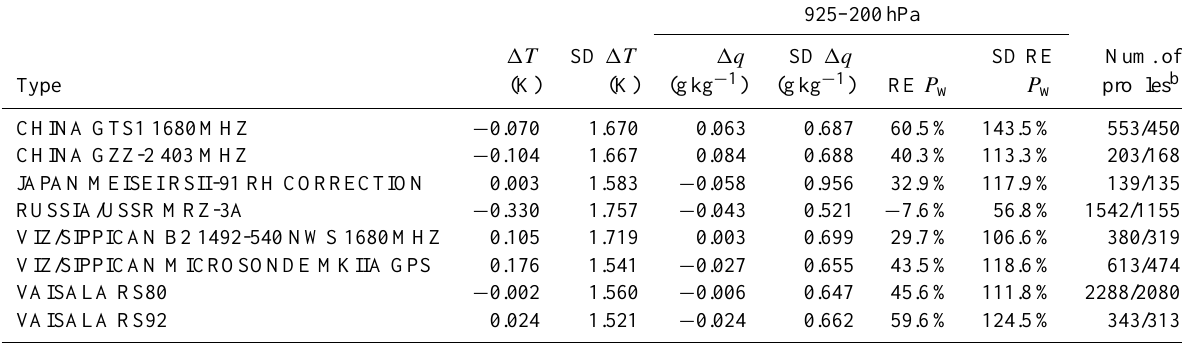
Table 2. Mean bias of different radiosonde types between wetPrf and radiosonde a